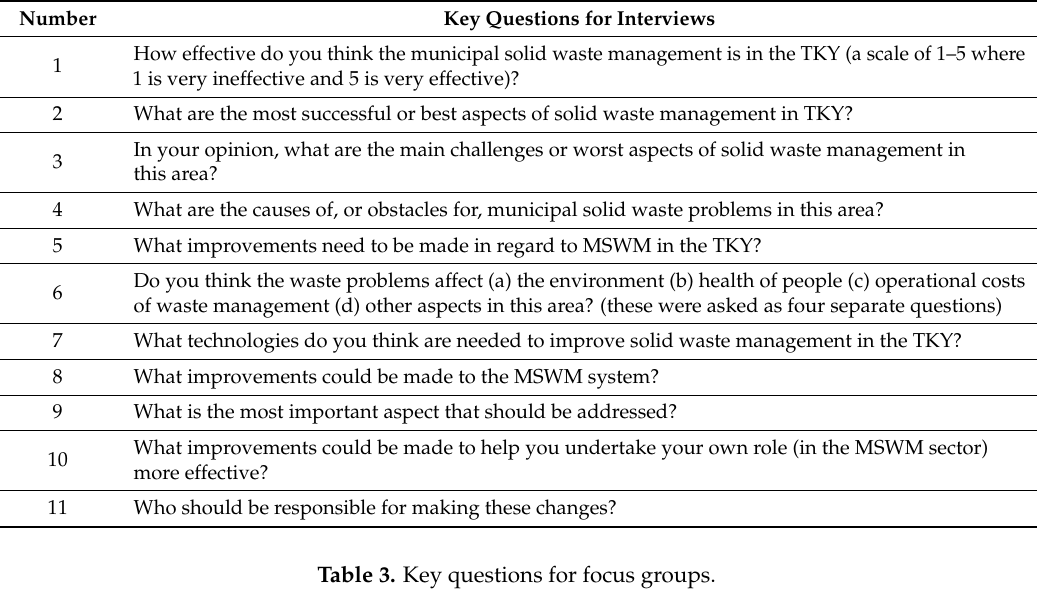
Table 2. Key questions for interviews (note: these interviews were semi-structured, and 3 unstructured interviews were also conducted).